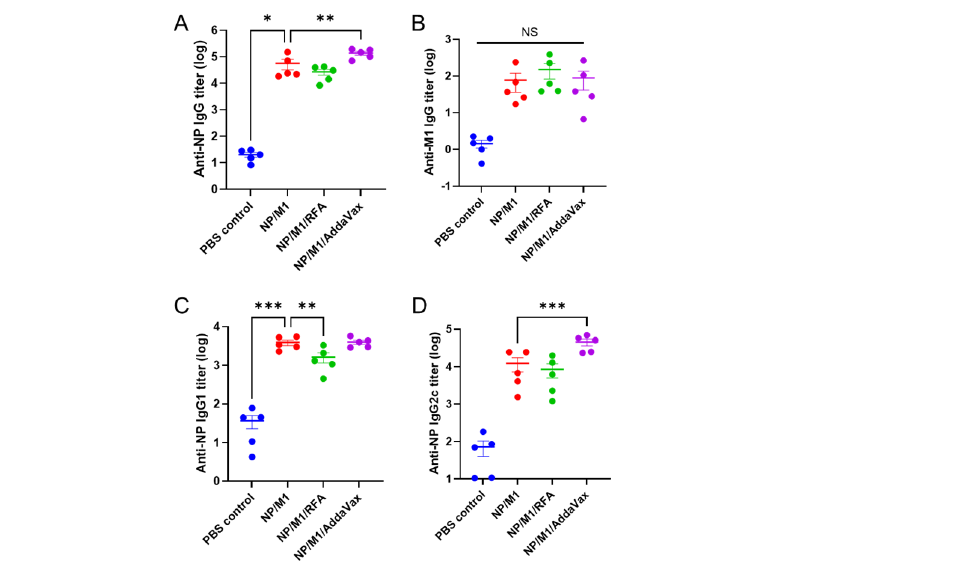
Figure 3. RFA had a minimal effect on NP and M1-induced antibody responses. Anti-NP and anti-M1 antibody responses were evaluated 3 weeks after boost. ( A ) Serum anti-NP IgG titer. ( B ) Serum anti-M1 IgG titer. ( C ) Serum anti-NP IgG1 titer. ( D ) Serum anti-NP IgG2c titer. n = 5. One-way ANOVA with Fisher’s LSD test was used to compare differences between NP/M1 and other groups. *, p < 0.05; **, p < 0.01; ***, p < 0.001; NS, not significant.